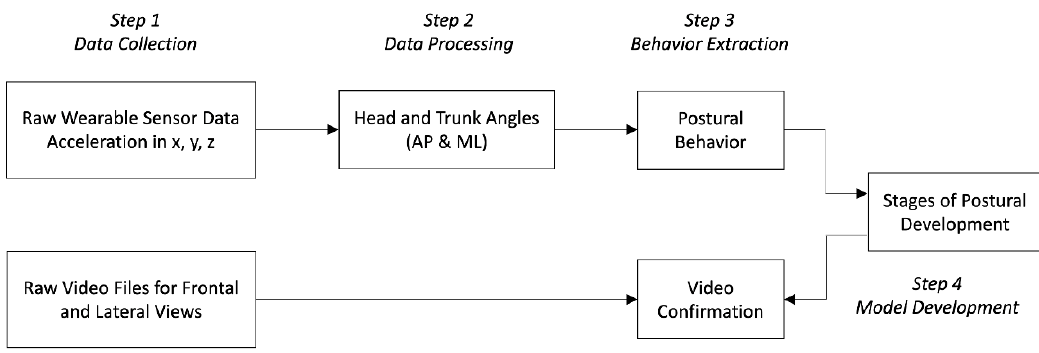
Figure 3. Steps used to process accelerometry data into postural development stage.